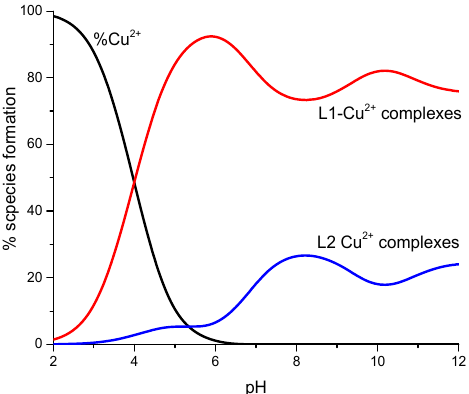
Figure 2. The UV ‐ Vis spectra for the solution with an equimolar quantity of ( a ) L1 and Cu(II) ions and ( b ) L2 and Cu(II) ions, at pH between 2.5 and 11.0. ( c ) The comparison of the experimental spectra for L1 at pH 4.0 (black) and L2 at pH 5.5 (red) obtained by the subtraction of the Cu(H 2 O) 62+ spectrum. The CD spectra for the solution with an equimolar quantity of ( d ) L1 − c(GlyHisProHisLys) and ( e ) L2 − c(GlyHisGlyHisLys) with Cu(II) ions at pH between 2.5 and 11.0.